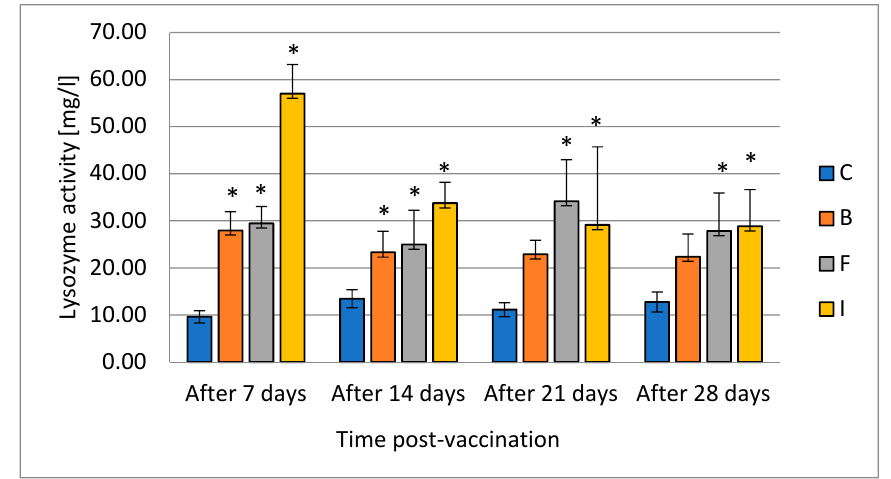
Figure 1. The effects of various routes of vaccination against A. salmonicida on lysozyme activity in pikeperch serum (mean value ± SD, n = 9, * statistical significance p ≤ 0.05). Ceruloplasmin level was lowered during the first sampling 7 days after vaccination in feed and injection (Figure 2). There was no change in this parameter in the bath-vaccinated group compared with the control.